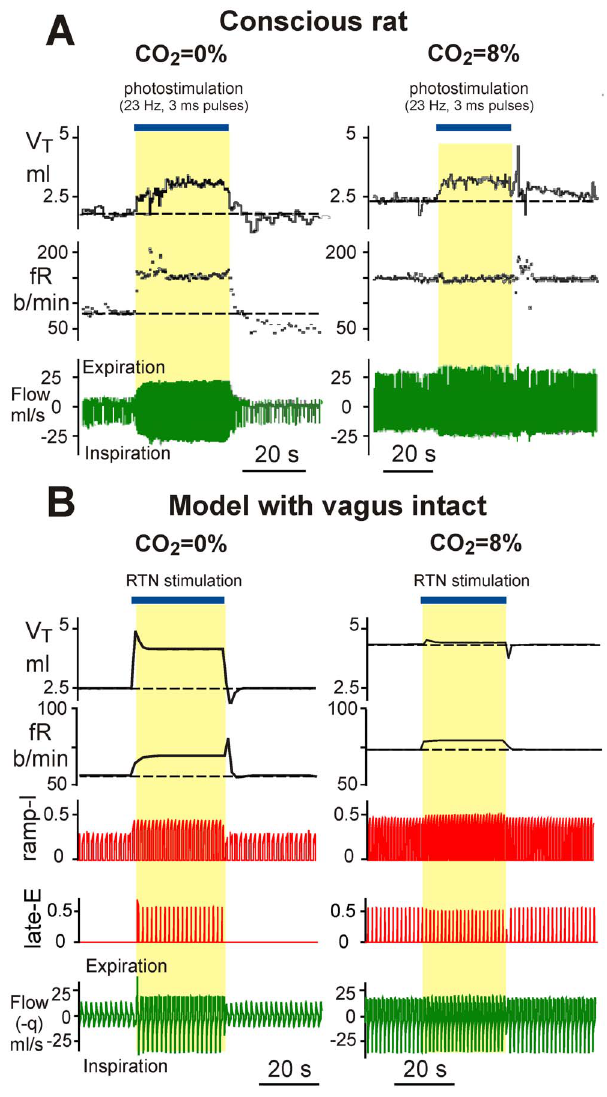
Figure 8. Comparison of model simulations with experimental data. A . Breathing stimulation elicited in conscious adult rat in a flow- through, whole-body plethysmography chamber by photostimulation via channelrodopsin genetically engineered in RTN Phox2b-expressing glutamatergic neurons. The left diagrams were constructed for hyperoxic normocapnia (100% O 2 ), and the right diagrams for hypercapnia (8% CO 2 , balance O 2 ). Continuous RTN stimulation (23 Hz, 3 ms pulses, 30 s total duration, blue bar at the top) raised tidal volume, V T , and breathing frequency, fR. During hyperoxic hypercapnia (right), RTN photostimulation produced a small increase in V T but no increase in fR. Adapted from Abbott et al. [52], Fig. 1B, with permission. B . The results of our simulations. An additional 30s-duration increase in the blood CO 2 level ( D p c =30 mmHg, blue bar at the top) was applied in the normocapnic case (left) and on the background of simulated hypercapnia ( f cm =8%) (right).